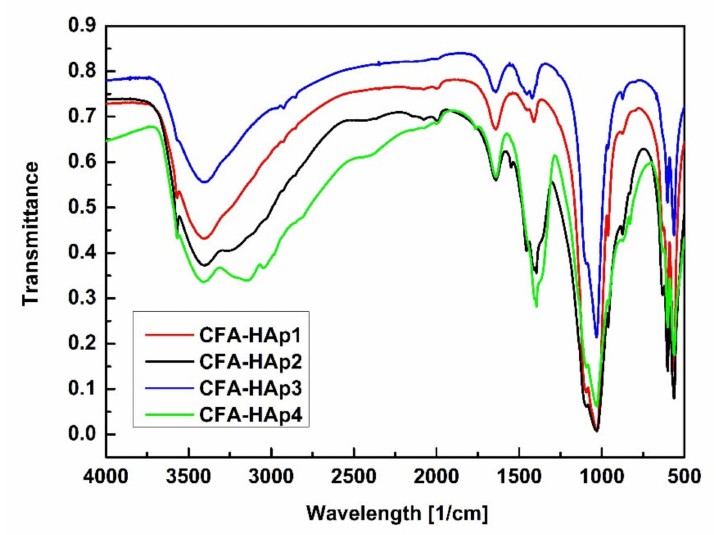
Figure 1. FT-IR spectra of the CFA–HAp1–4